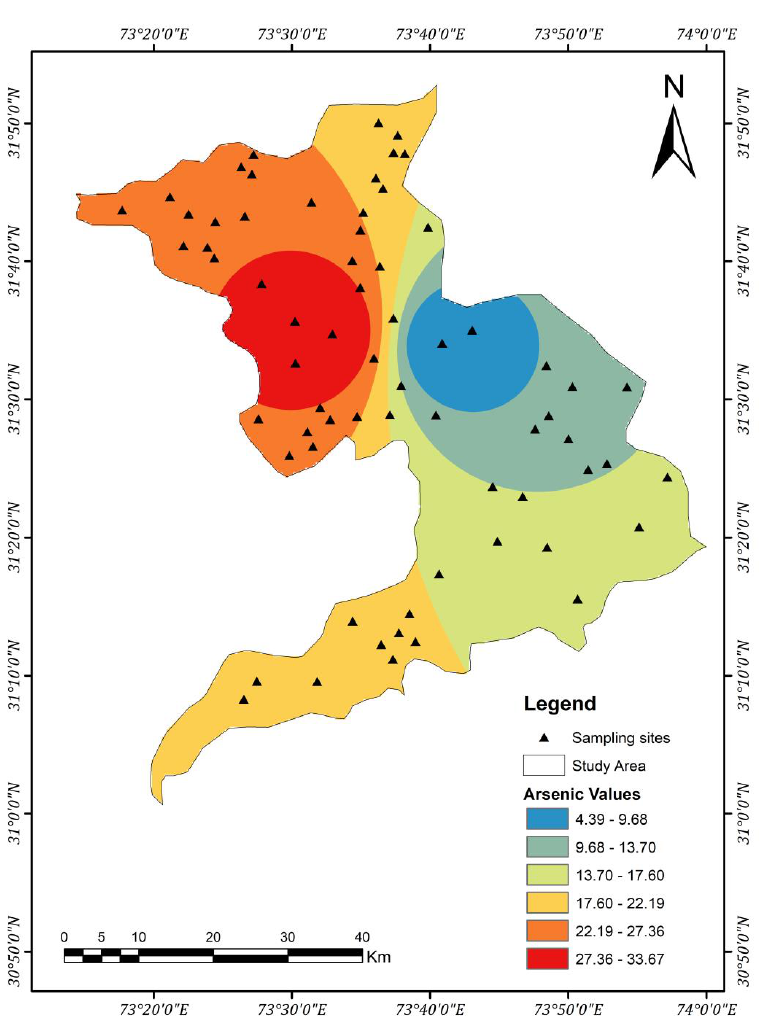
Figure 2. Map of the spatial distribution of arsenic in the research area.